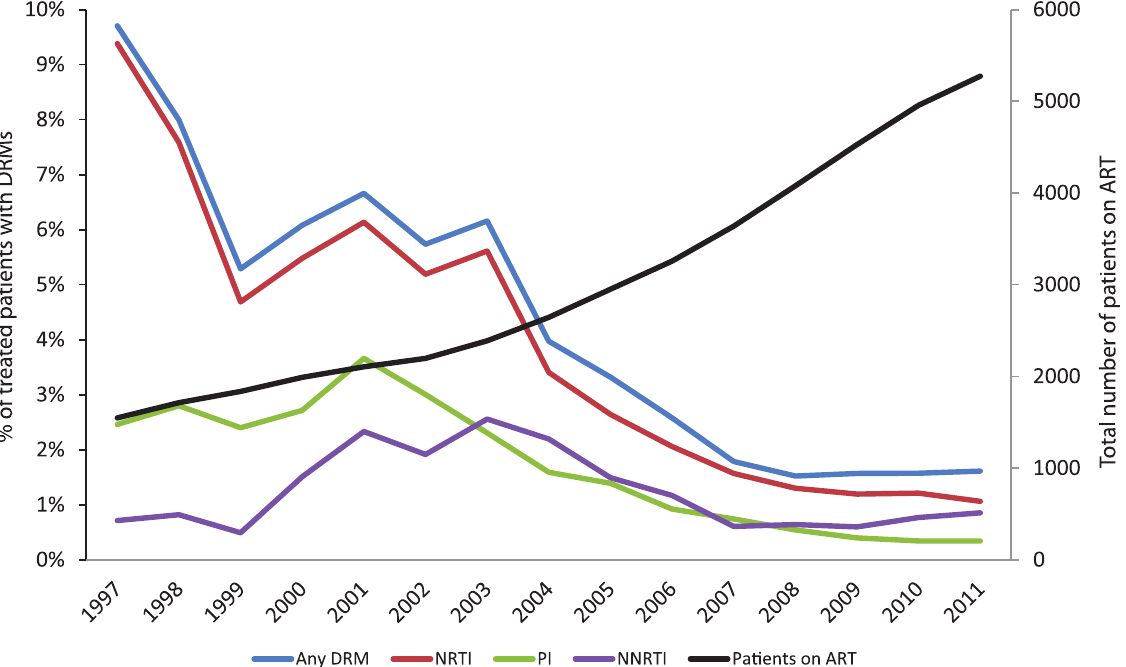
Figure 3. Prevalence of major resistance mutations among all ART-experienced patients 1997–2011. The coloured graphs show the proportion of patients on treatment each year that had at least one major drug resistance mutation in that year. Any DRM includes all patients with at least one major resistance mutation to any drug class while separate graphs show the prevalence of $ 1 mutation associated with resistance to NRTI, NNRTI and PI respectively. The black line illustrates the total number of Swedish HIV-patients on ART each calendar year.